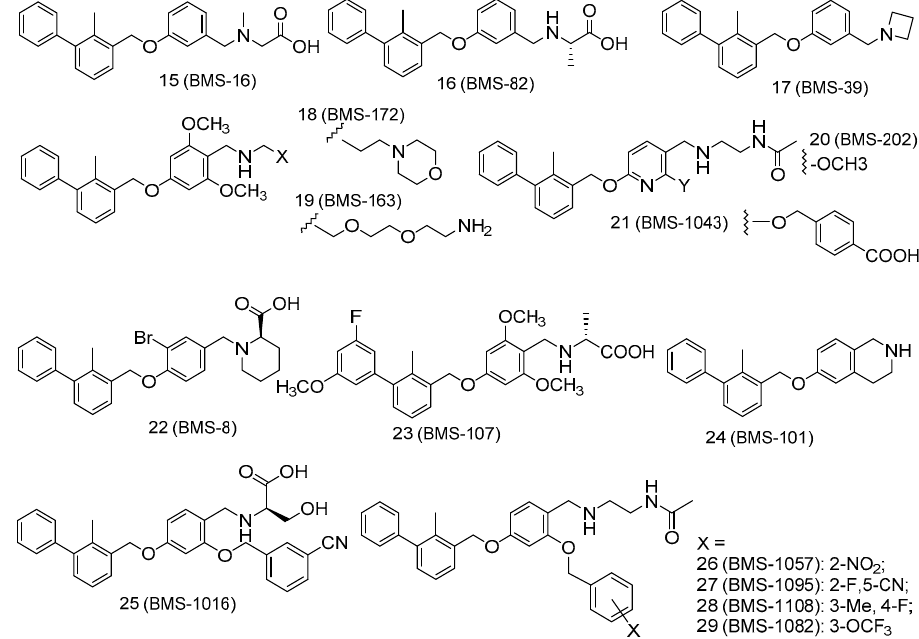
Figure 2. Structures of the PD-1/PD-L1 complex inhibitors (15–29) used in docking